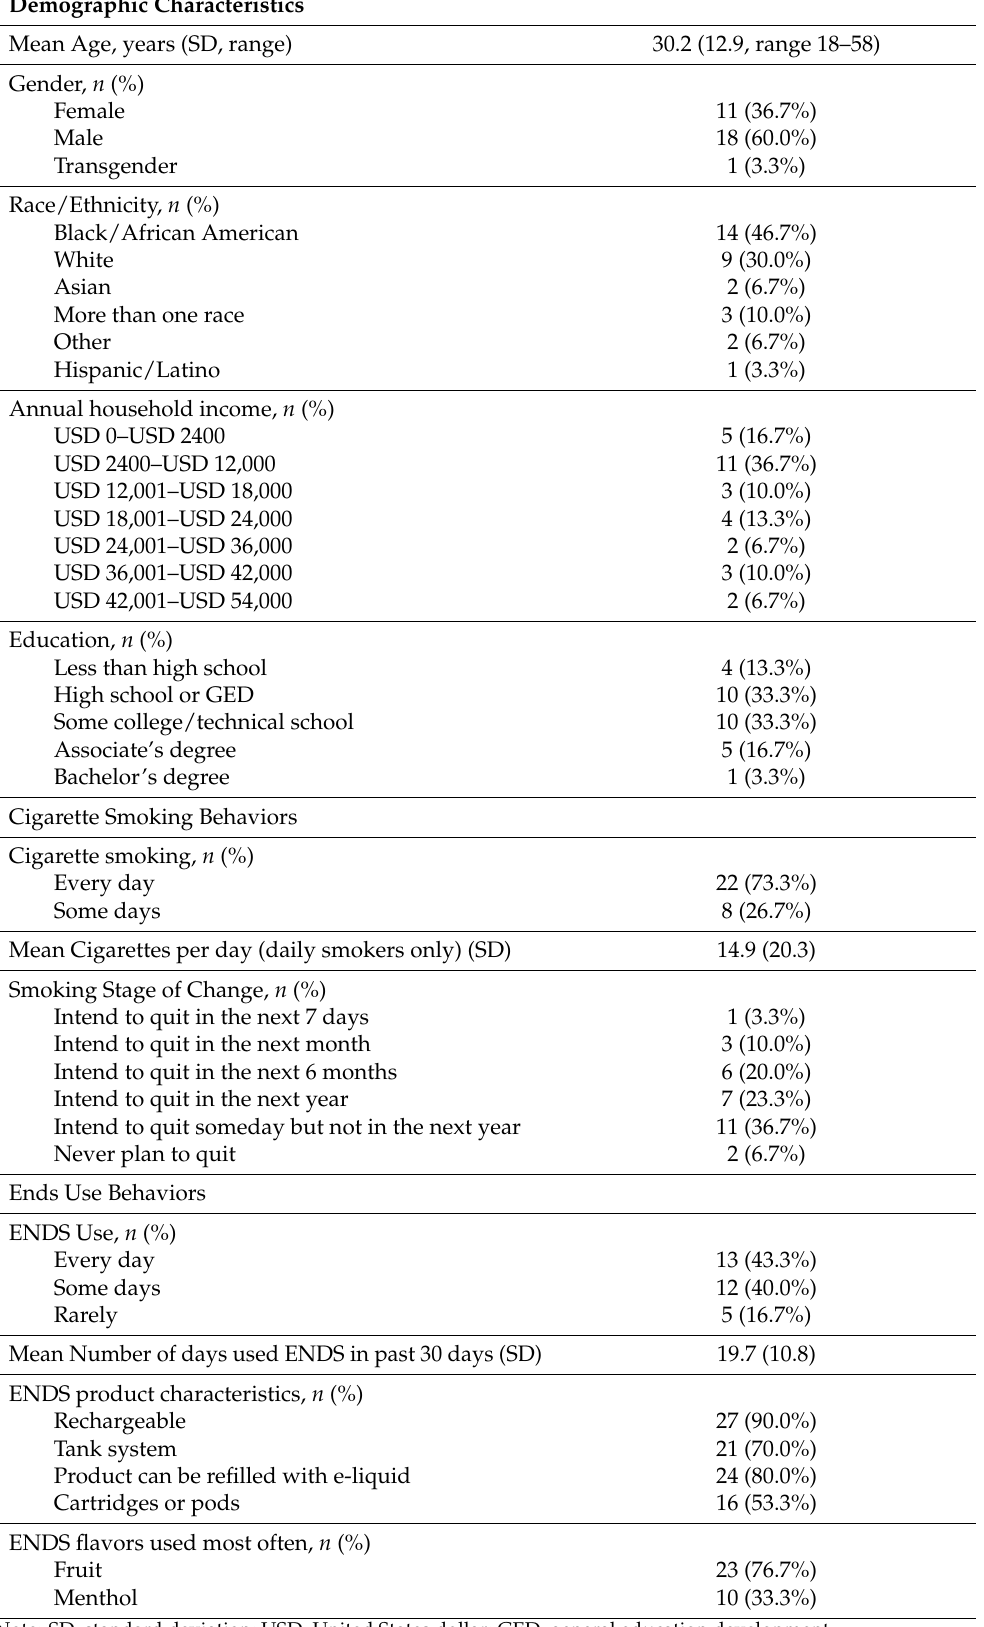
Table 1. Participant Characteristics ( N =